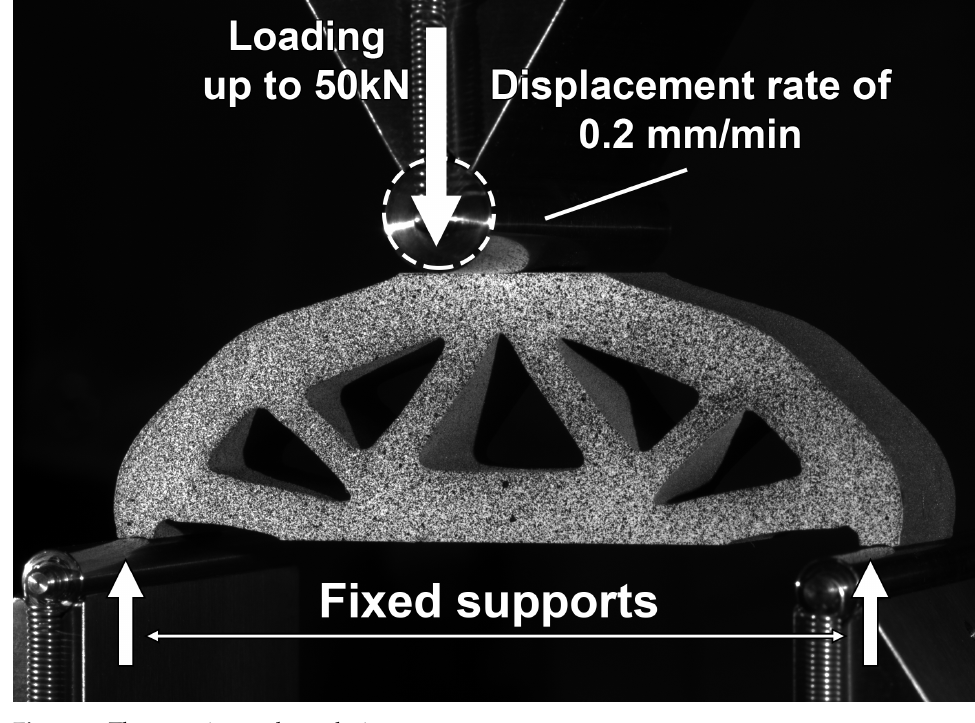
Figure 8. The experimental test design.